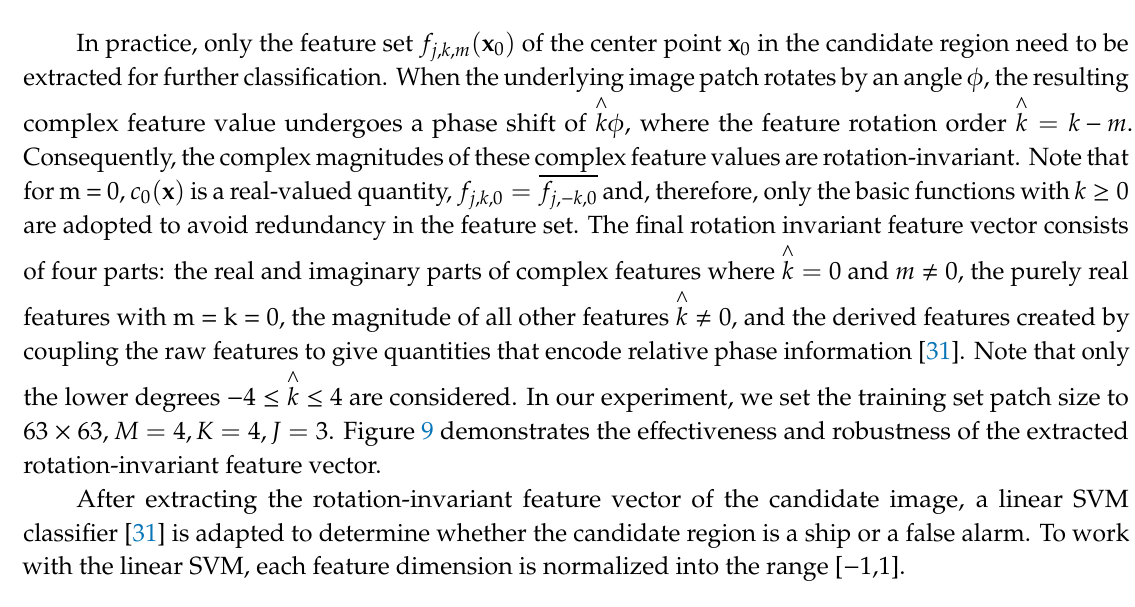
Figure 8. The circular basis functions with J = 3, K = 4(only 0 k ≥ displayed)